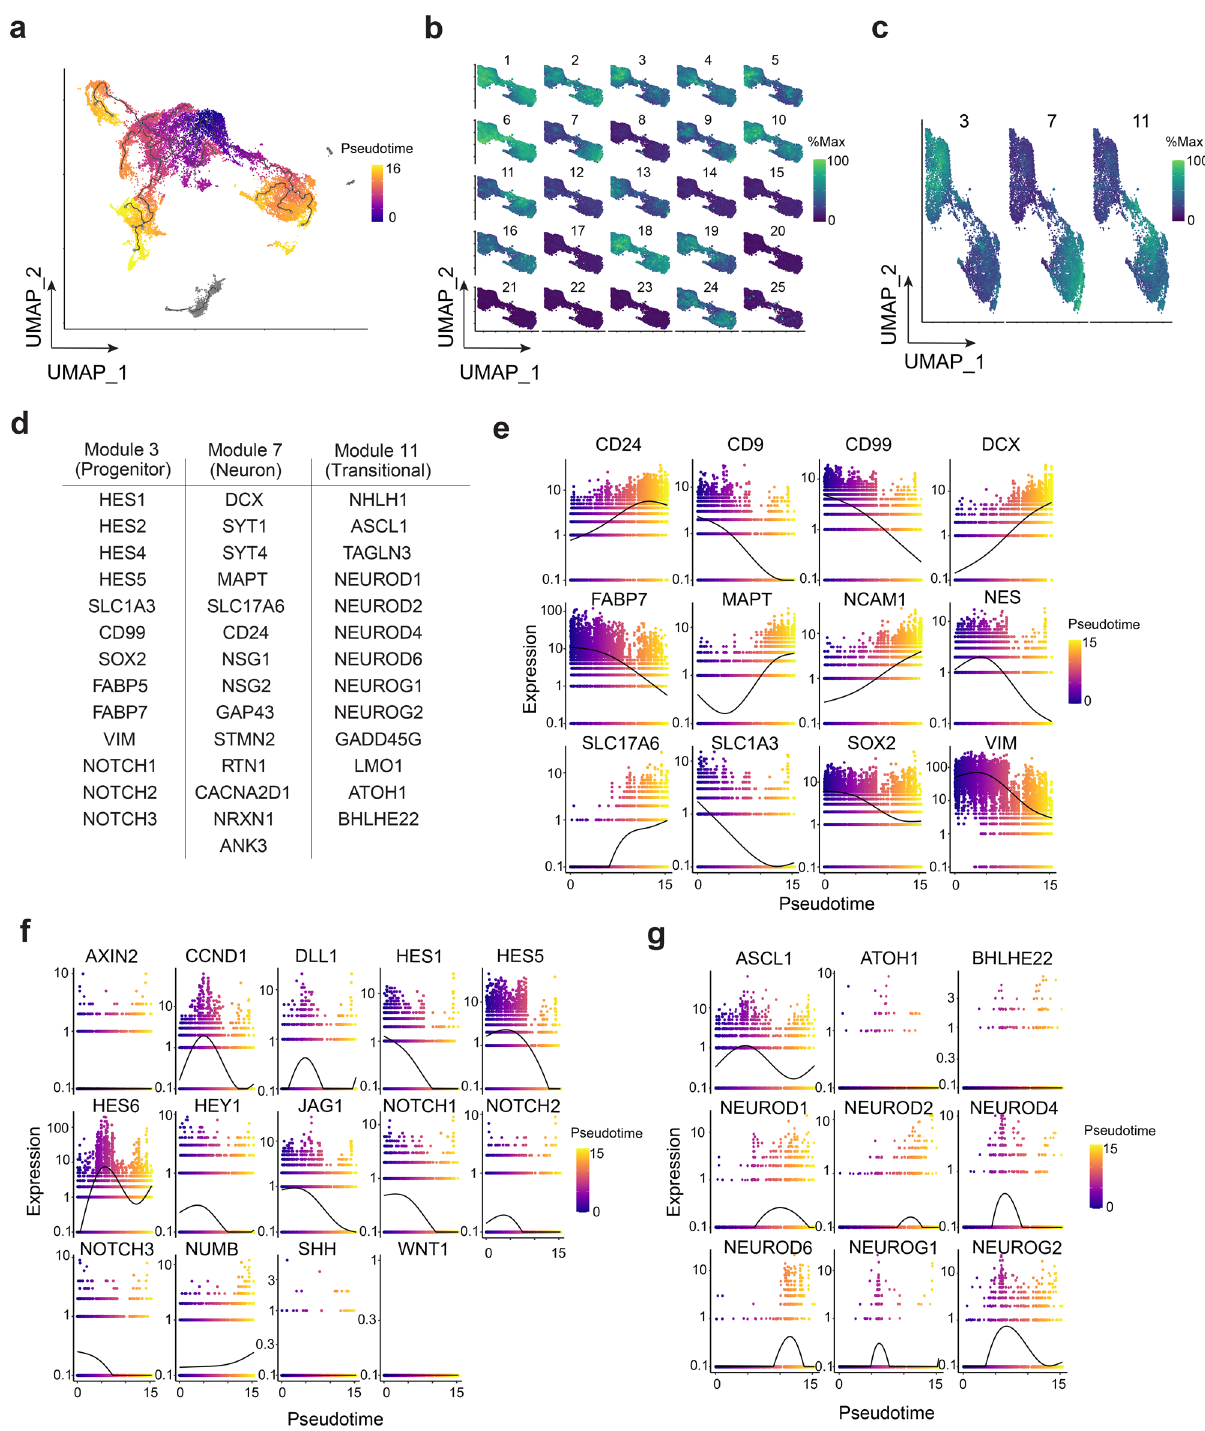
Figure 2. Single cell trajectory analysis of a human iPSC-derived neural mixed culture. ( a ) UMAP of learned trajectory graph from integrated cell type clustering with cells ordered in pseudotime. ( b ) Co-regulated gene modules of predicted lineage subset in (a) and visualized as scaled expression to percent of maximum expression. ( c ) Gene modules from (b) defined as progenitor (module 3), neuronal (module 7), and transitional state (module 11). ( d ) Table of example genes expressed in modules from (c). ( e ) Expression of radial glial and neuronal markers varying as a function of pseudotime on lineage subset from (b). ( f ) Expression of Notch, Shh, and Wnt related pathway genes as a function of pseudotime on lineage subset from ( b ). ( g ) Expression of gene module 11 transitional state bHLH transcription factors as a function of pseudotime on lineage subset from ( b